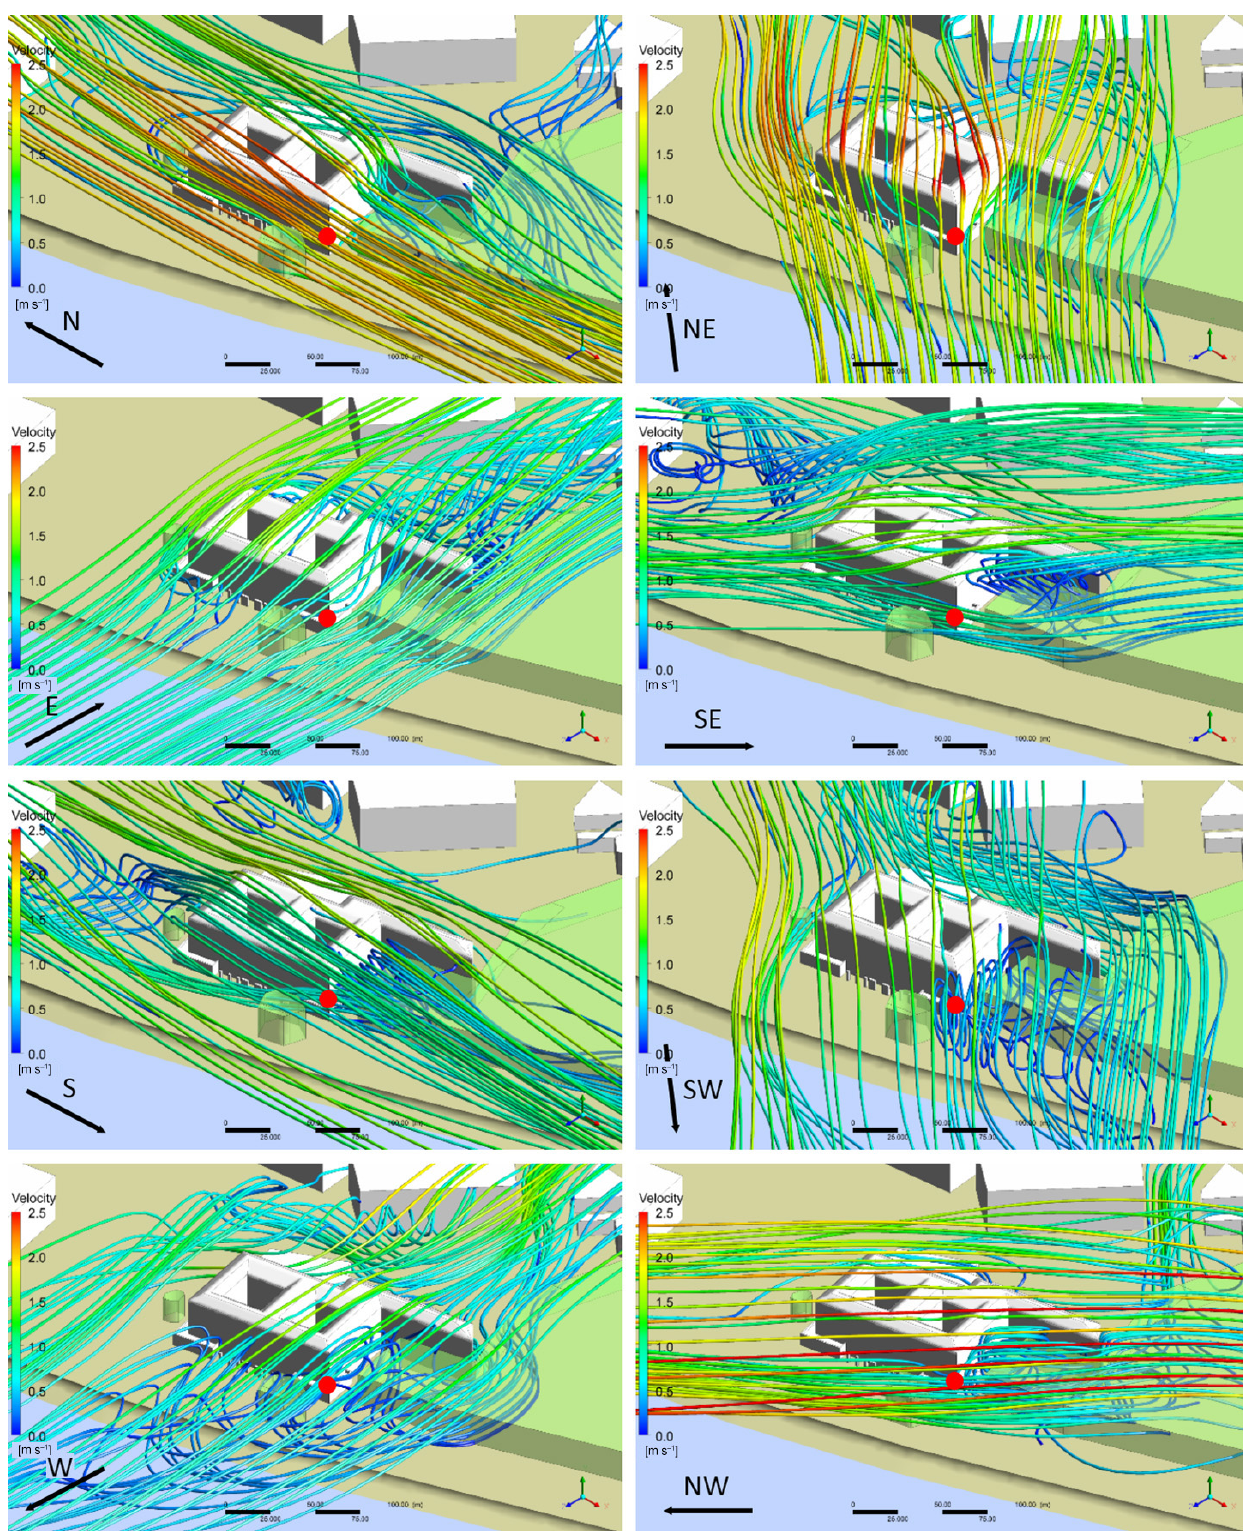
Figure 7. Path lines and speeds around the BpART facility for the eight major wind sectors (N, NE, E, SE, S, SW, W and NW) in summer (vegetation with leaves) in a perspective view. The wind directions are marked by an arrow and letters, and the location of the platform is indicated by a red dot in the